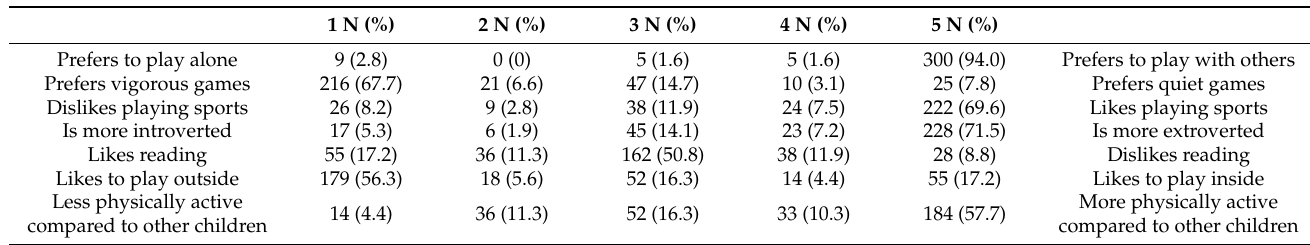
Table 2. NPAQ response frequencies.